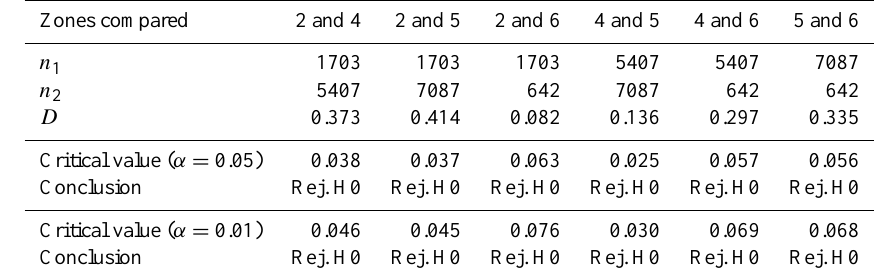
Table 12. Summary of results obtained in Kolmogorov–Smirnov test for size.